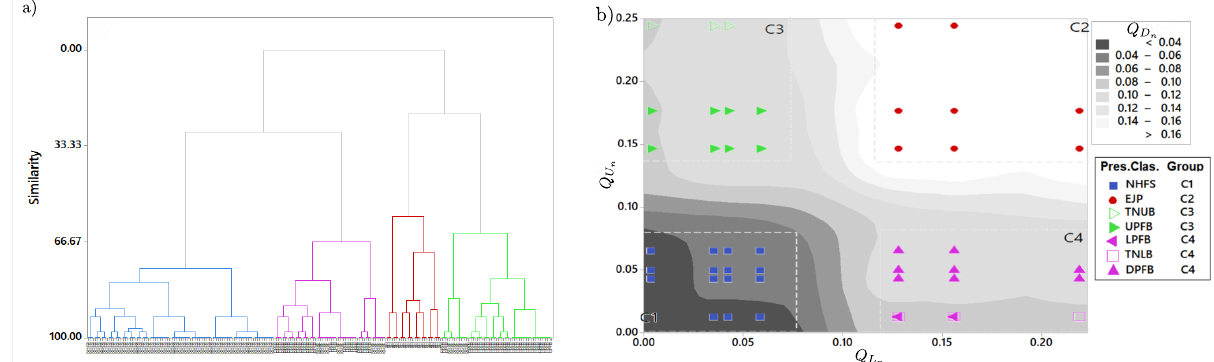
, Q L and Q D n n n